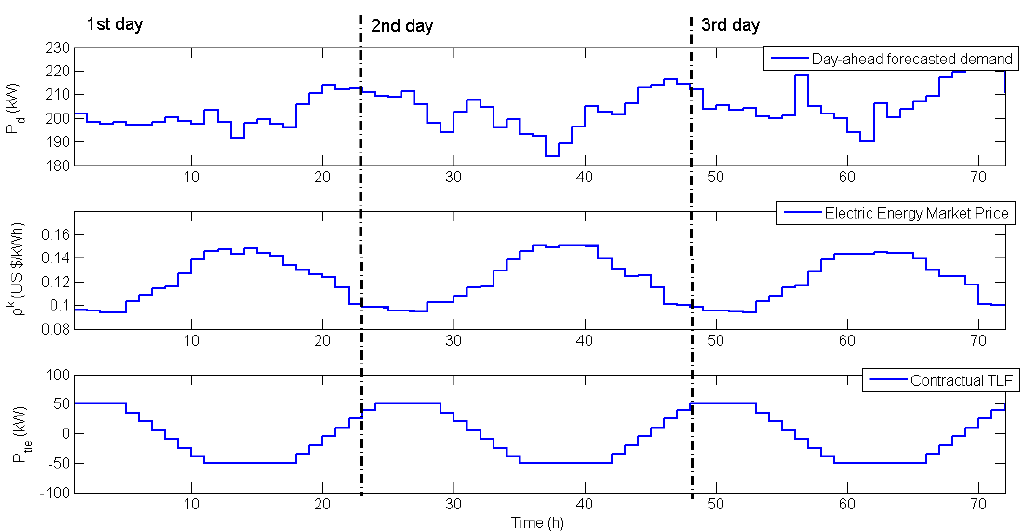
Figure 5. Demands, electricity prices, and TLF schedules for the next 72 h. Table 1. Simulation data for DERs and tie-line.